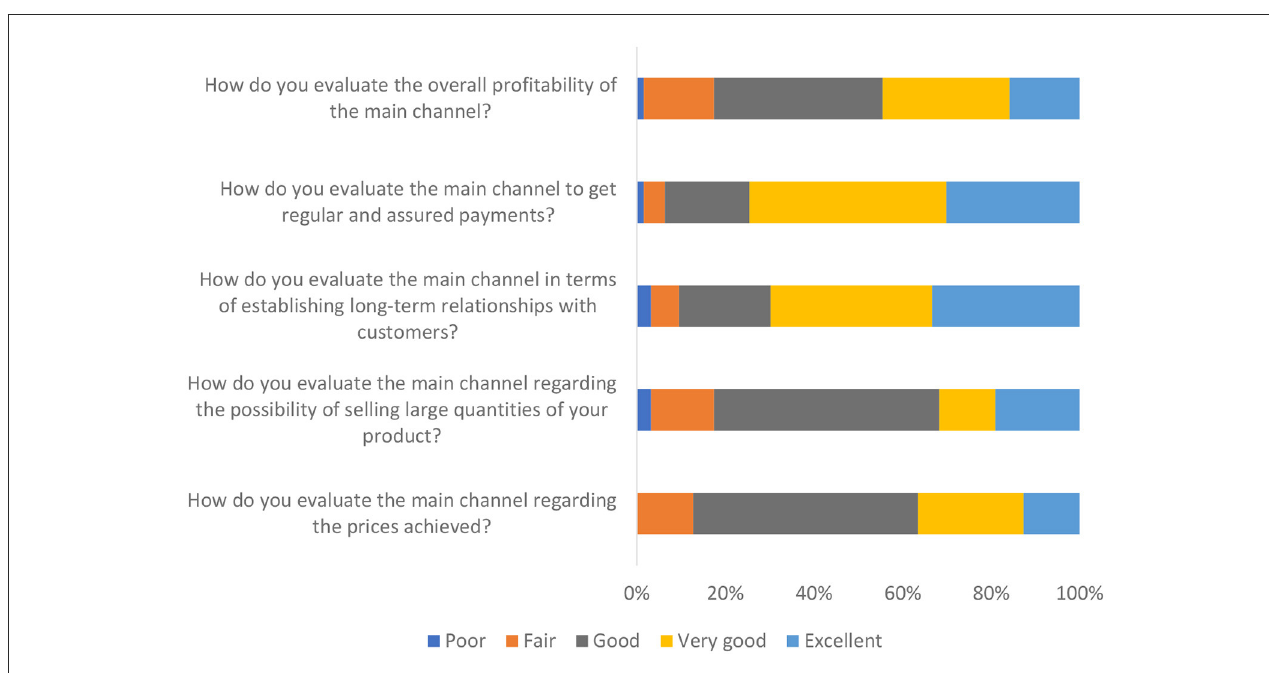
FIGURE1 Attractiveness of short supply chains (producer